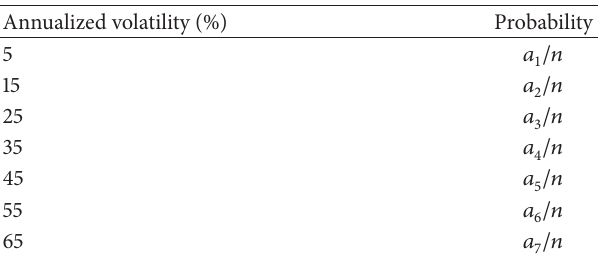
Table 2: The distribution series of annualized volatility of spot copper